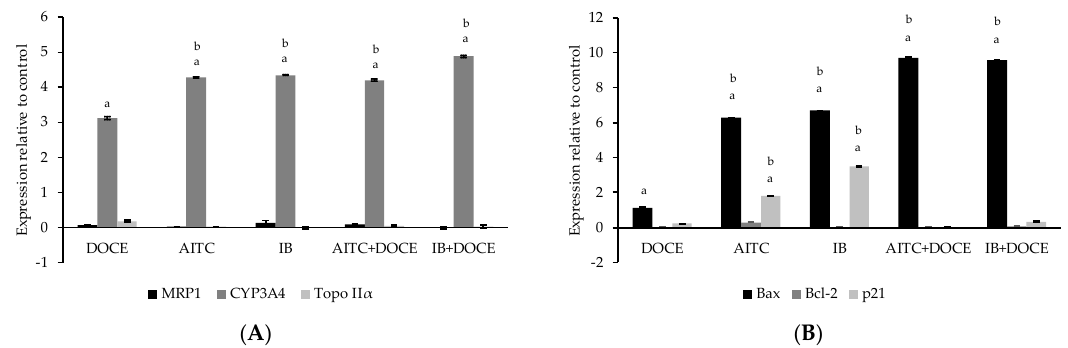
Figure 6. E ff ect of allyl-isothiocyanate (AITC), iberin (IB) and / or docetaxel (DOCE) on gene expression (2 − ∆∆ C t ) of: ( A ) MRP1, CYP3A4 and Topo II α ; ( B ) Bax, Bcl-2 and p21. Data are shown as the mean ± SD of three independent experiments. Values higher than one were considered positive in comparison to cells treated with control. a treatment significantly di ff erent compared with control ( p < 0.05). b treatment significantly di ff erent compared with DOCE ( p < 0.05).